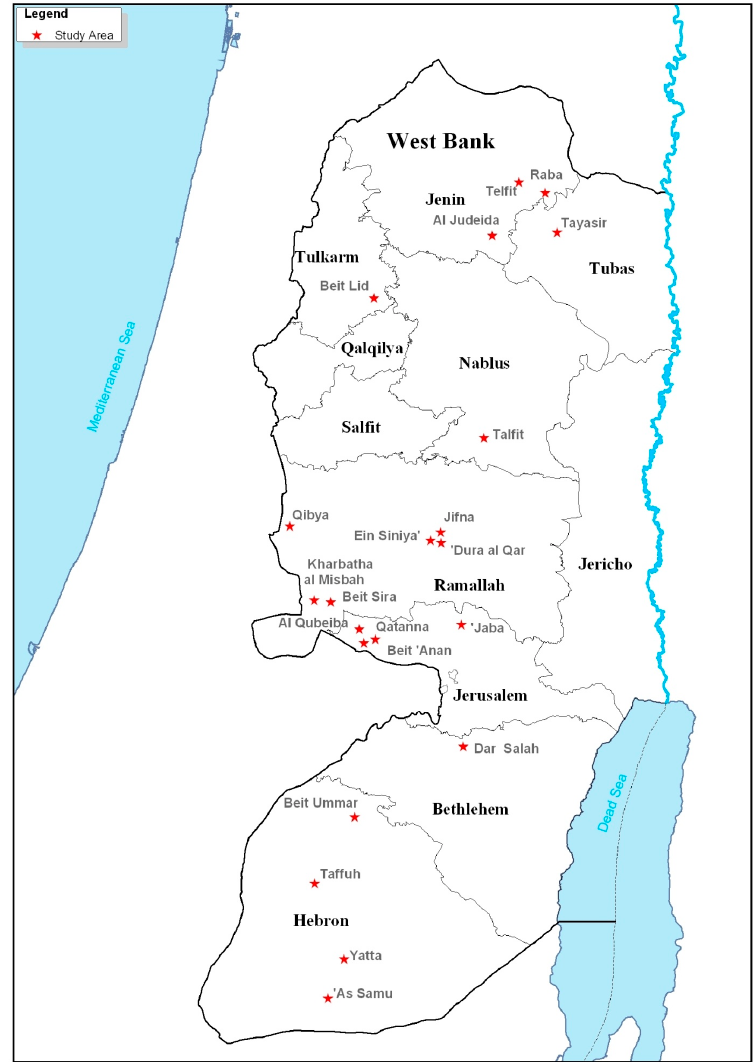
Figure 4. Study area in eight governorates of the West Bank .